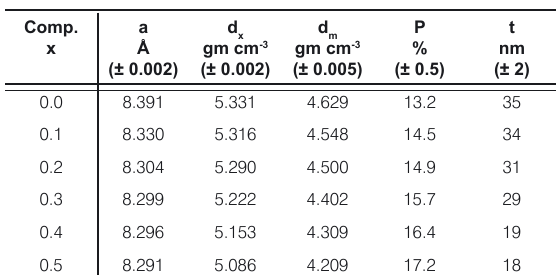
porosity (P) and particle size (t). Braket represents the error estimates.